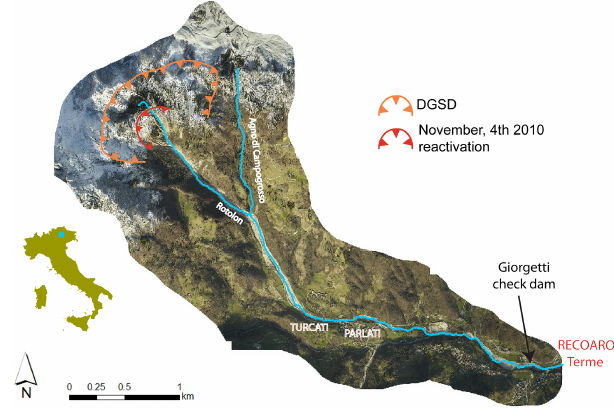
Figure 1. Study area: post-event orthophoto with the main hydro- graphic network and the landslides crowns